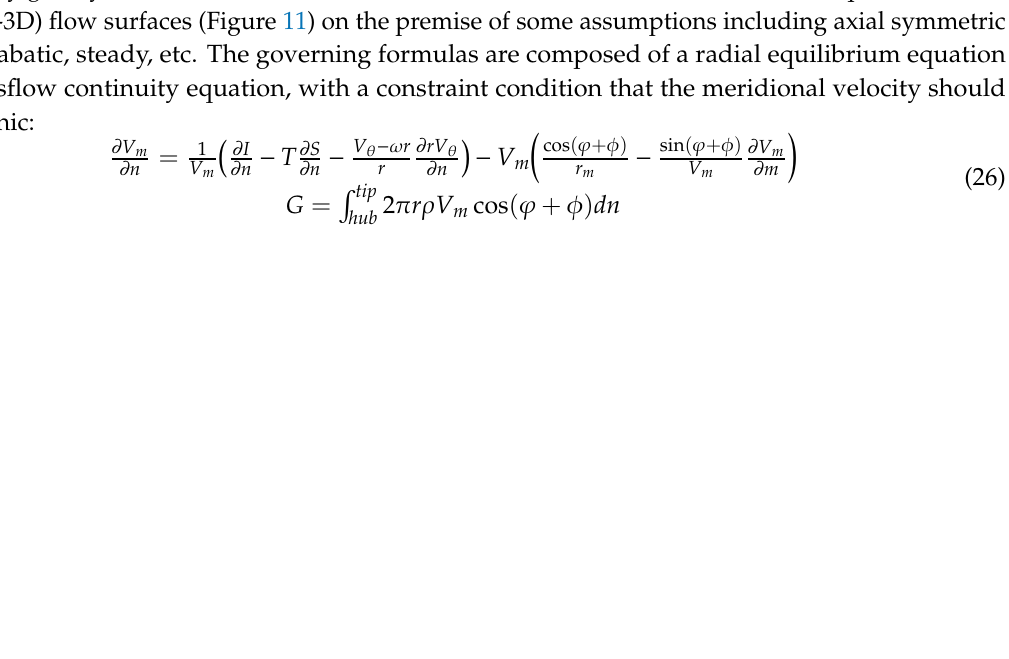
Figure 10. Validation of GPR models on whole data set; ( a ) deviation angle; ( b ) total pressure loss.